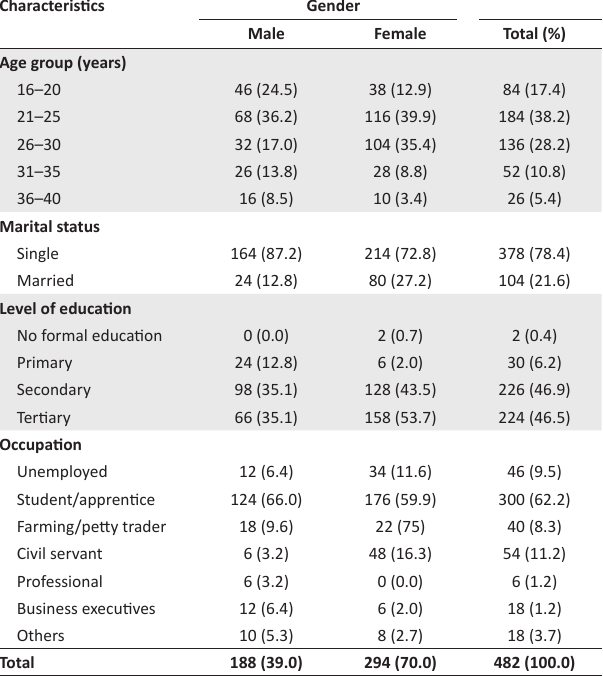
TABLE 1: Socio-demographic characteristics of the study